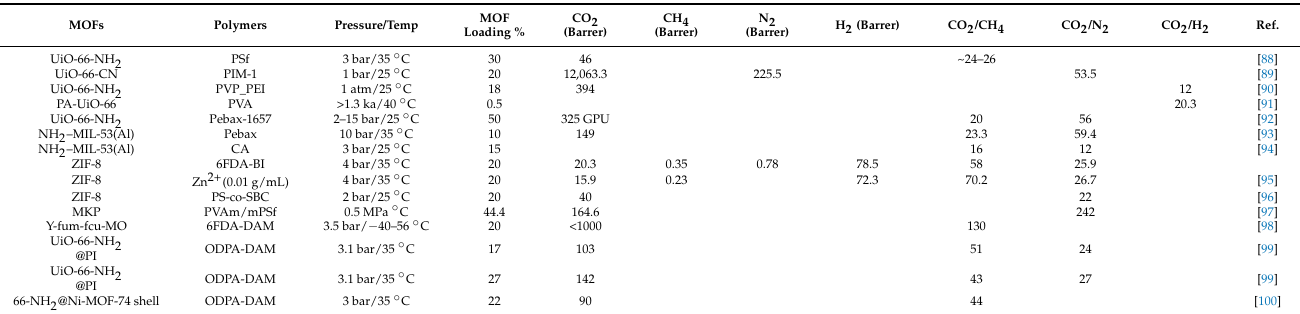
Table 2. Transport properties of MOF/polymer mixed matrix